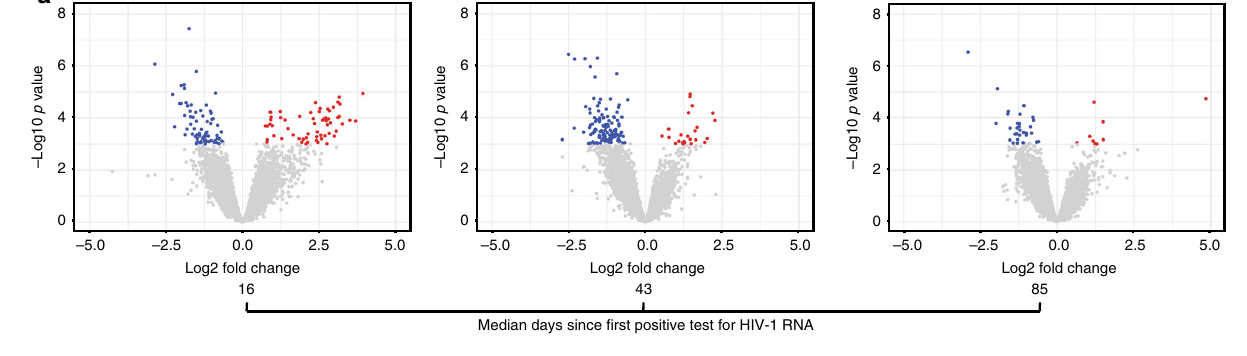
(Fig. 3g). The NK cell gene signature included enhanced expression of KLRD1 , GZMB , MICB , SLAMF7 , and KIR3DL1 ; the IFN γ production signature included IFNaR1 , TLR3 , and HAVCR2 ; and the negative regulation of viral entry pathway included upregulation of IFITIM1, 2, and 3 and TRIM5 . The MAIT cell GSEA data are indicative of not only activation and cell proliferation but also utilization of pathways more commonly af fi liated with the innate cellular compartment.